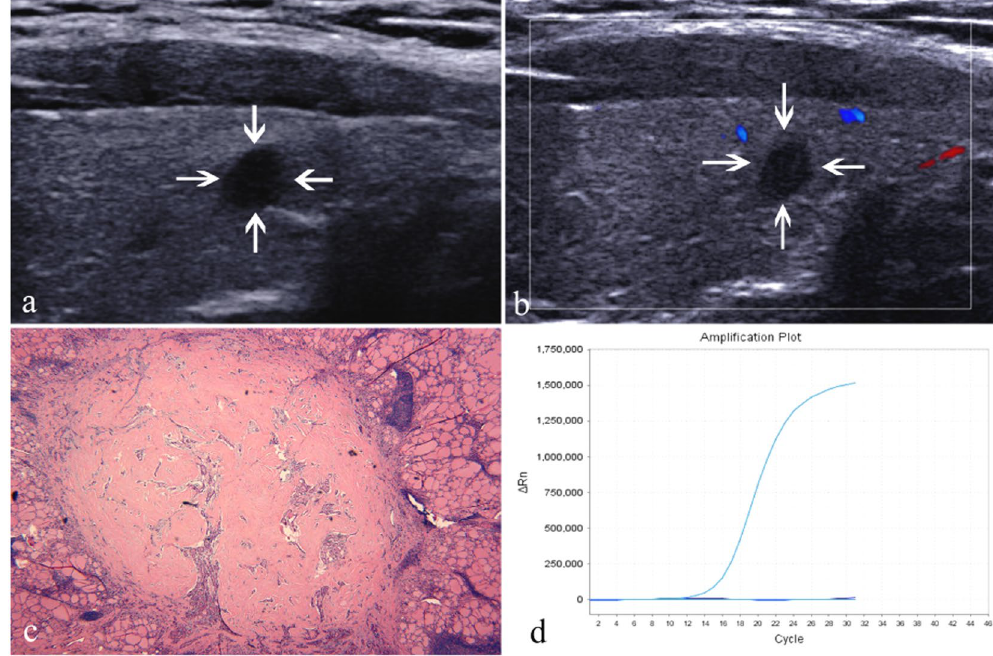
Figure 2. A 39-year-old woman with papillary thyroid microcarcinoma. ( a ) A solid, hypoechogenic, regular, well-defined and taller-than-wide nodule (arrows) without capsule contact is shown on US and no calcification is found in the nodule. ( b ) No blood flow is shown on color Doppler US. ( c ) Pathological examination confirms the diagnosis of papillary thyroid microcarcinoma and Hashimoto’s thyroiditis. (haematoxylin-eosin stain; original magnification, × 40). ( d ) The amplification plot of BRAF shows BRAF wild type. The purple curve, representative of the BRAF sample, overlaps the horizontal light blue reference line which suggests BRAF-